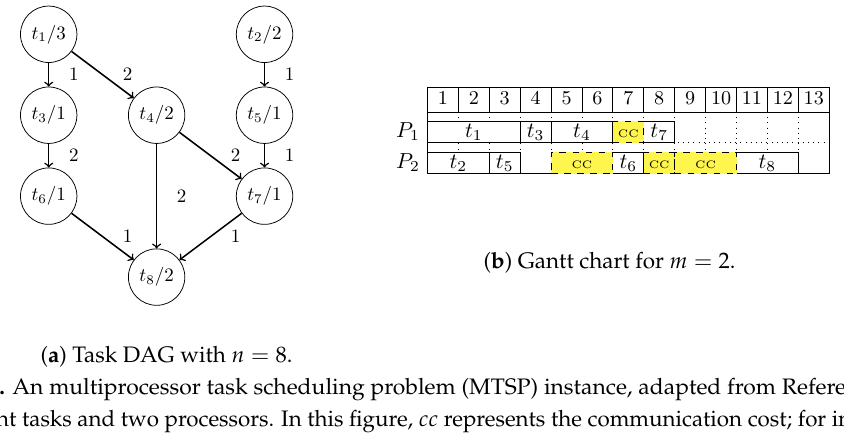
Figure 1. An multiprocessor task scheduling problem (MTSP) instance, adapted from Reference [3], with eight tasks and two processors. In this figure, cc represents the communication cost; for instance, t 6 waits two seconds to start its execution because task t 3 is sending a message throw